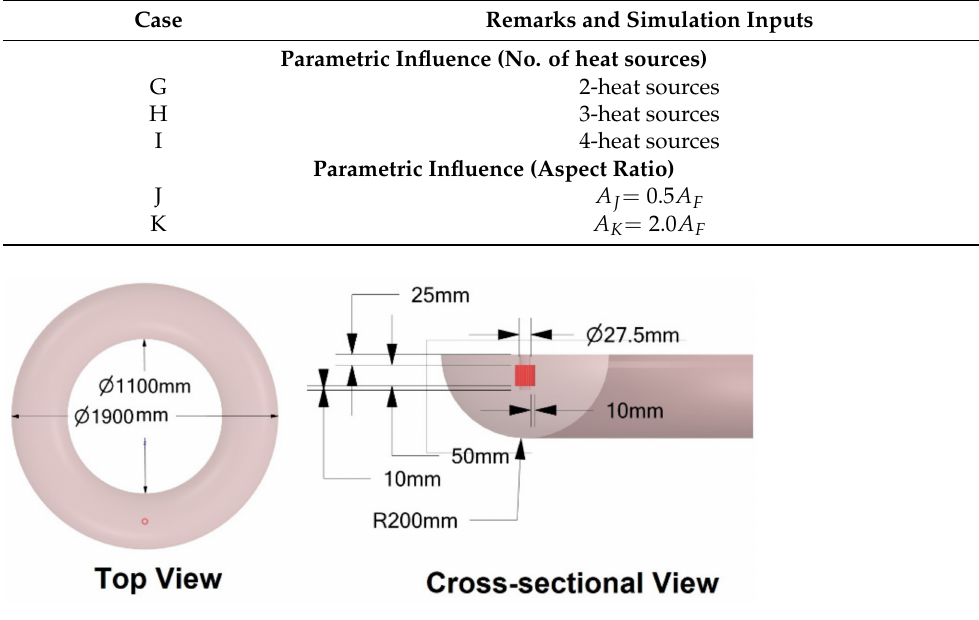
Figure 1. A schematic of the torus and the steam condensation region where the volumetric heat flux is